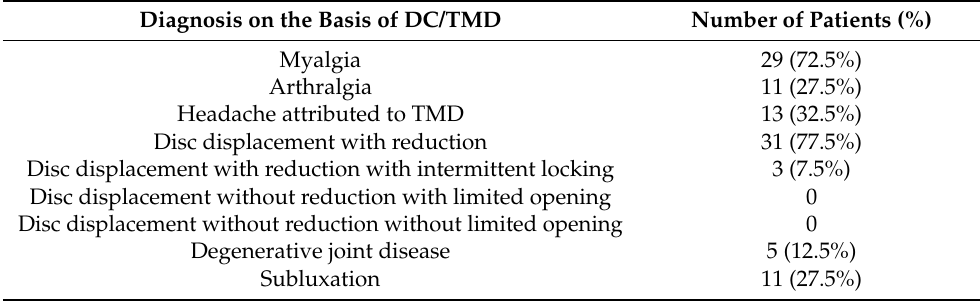
Table 2. The frequency of different diagnoses on the basis of DC/TMD among the examined patients within the study